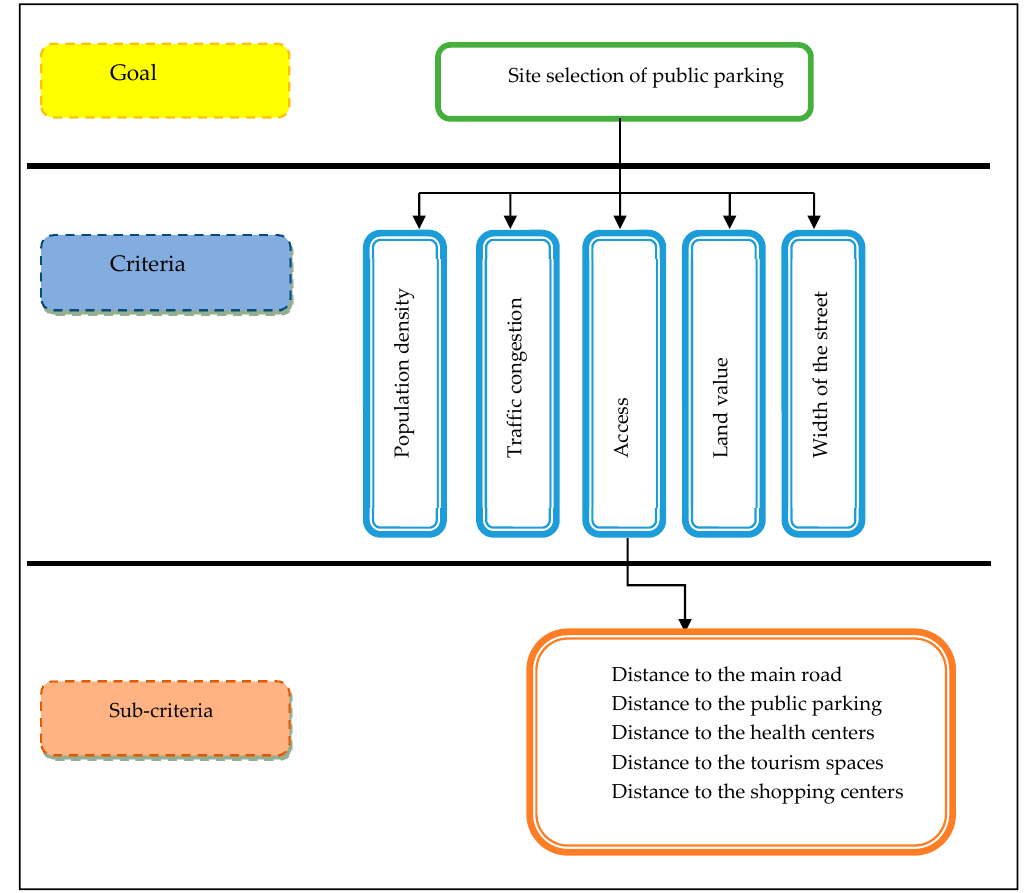
Figure 3. Hierarchy of criteria.